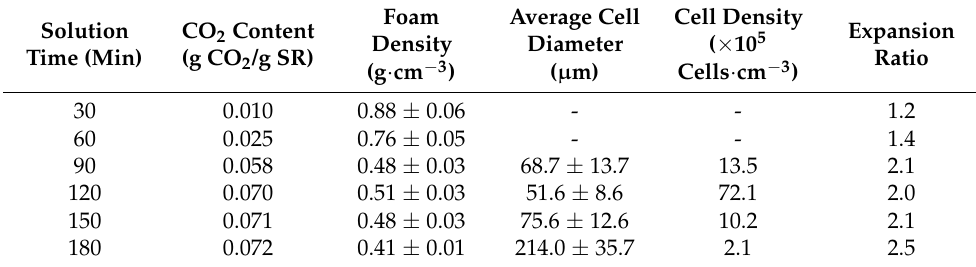
Table 3. Parameters of foamed samples with different CO 2 saturation